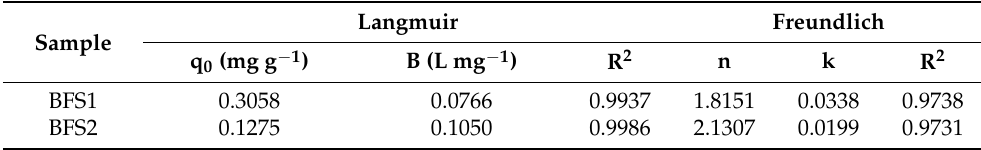
Table 1 . Adsorption isotherm model parameters of BFS * . Table 1. Adsorption isotherm model parameters of BFS